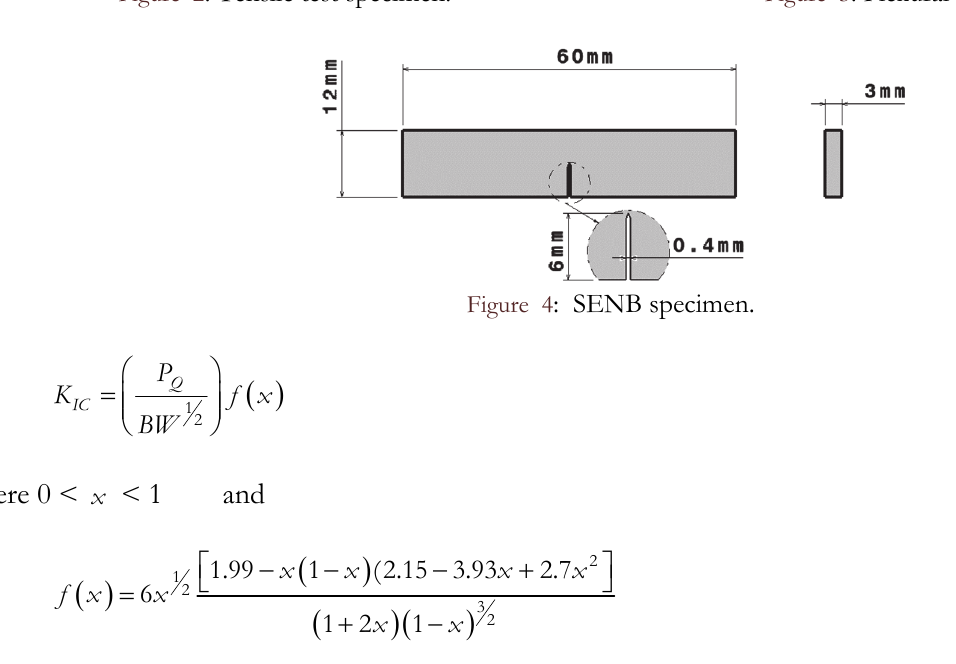
Figure 2 : Tensile test specimen. Figure 3 : Flexural test specimen.